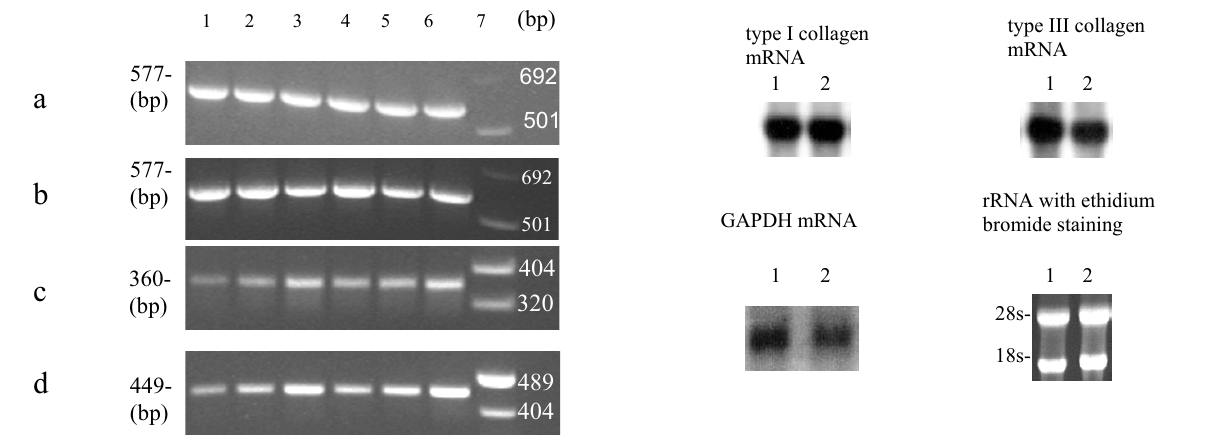
Figure 2 Northern Blot analysis of type I and type III collagen mRNA from cultured fibroblasts. The ratio of 28S to 18S rRNA (ribosomal RNA) was approximately 2 : 1 by ethidium bro- mide staining of denaturing agarose gel electrophoresis, indi- cating that no gross degradation of extracted RNA